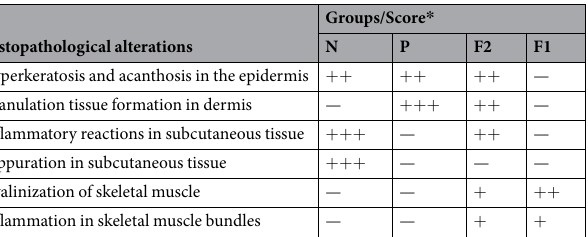
— — — + + Table 5. The severity of the histopathological alterations observed during skin autopsies of the different experimental groups. Score: +++ Severe, ++ Moderate, + Mild, —